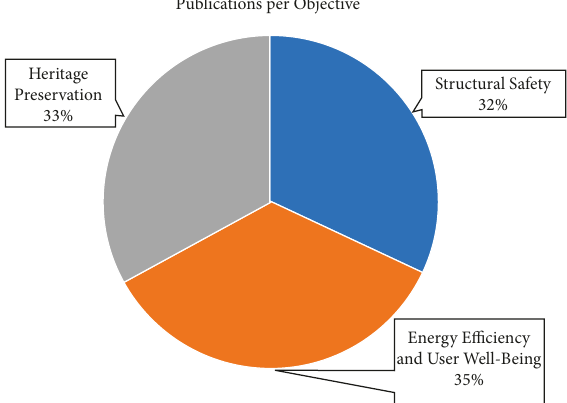
Energy Efficiency and User Well-Being